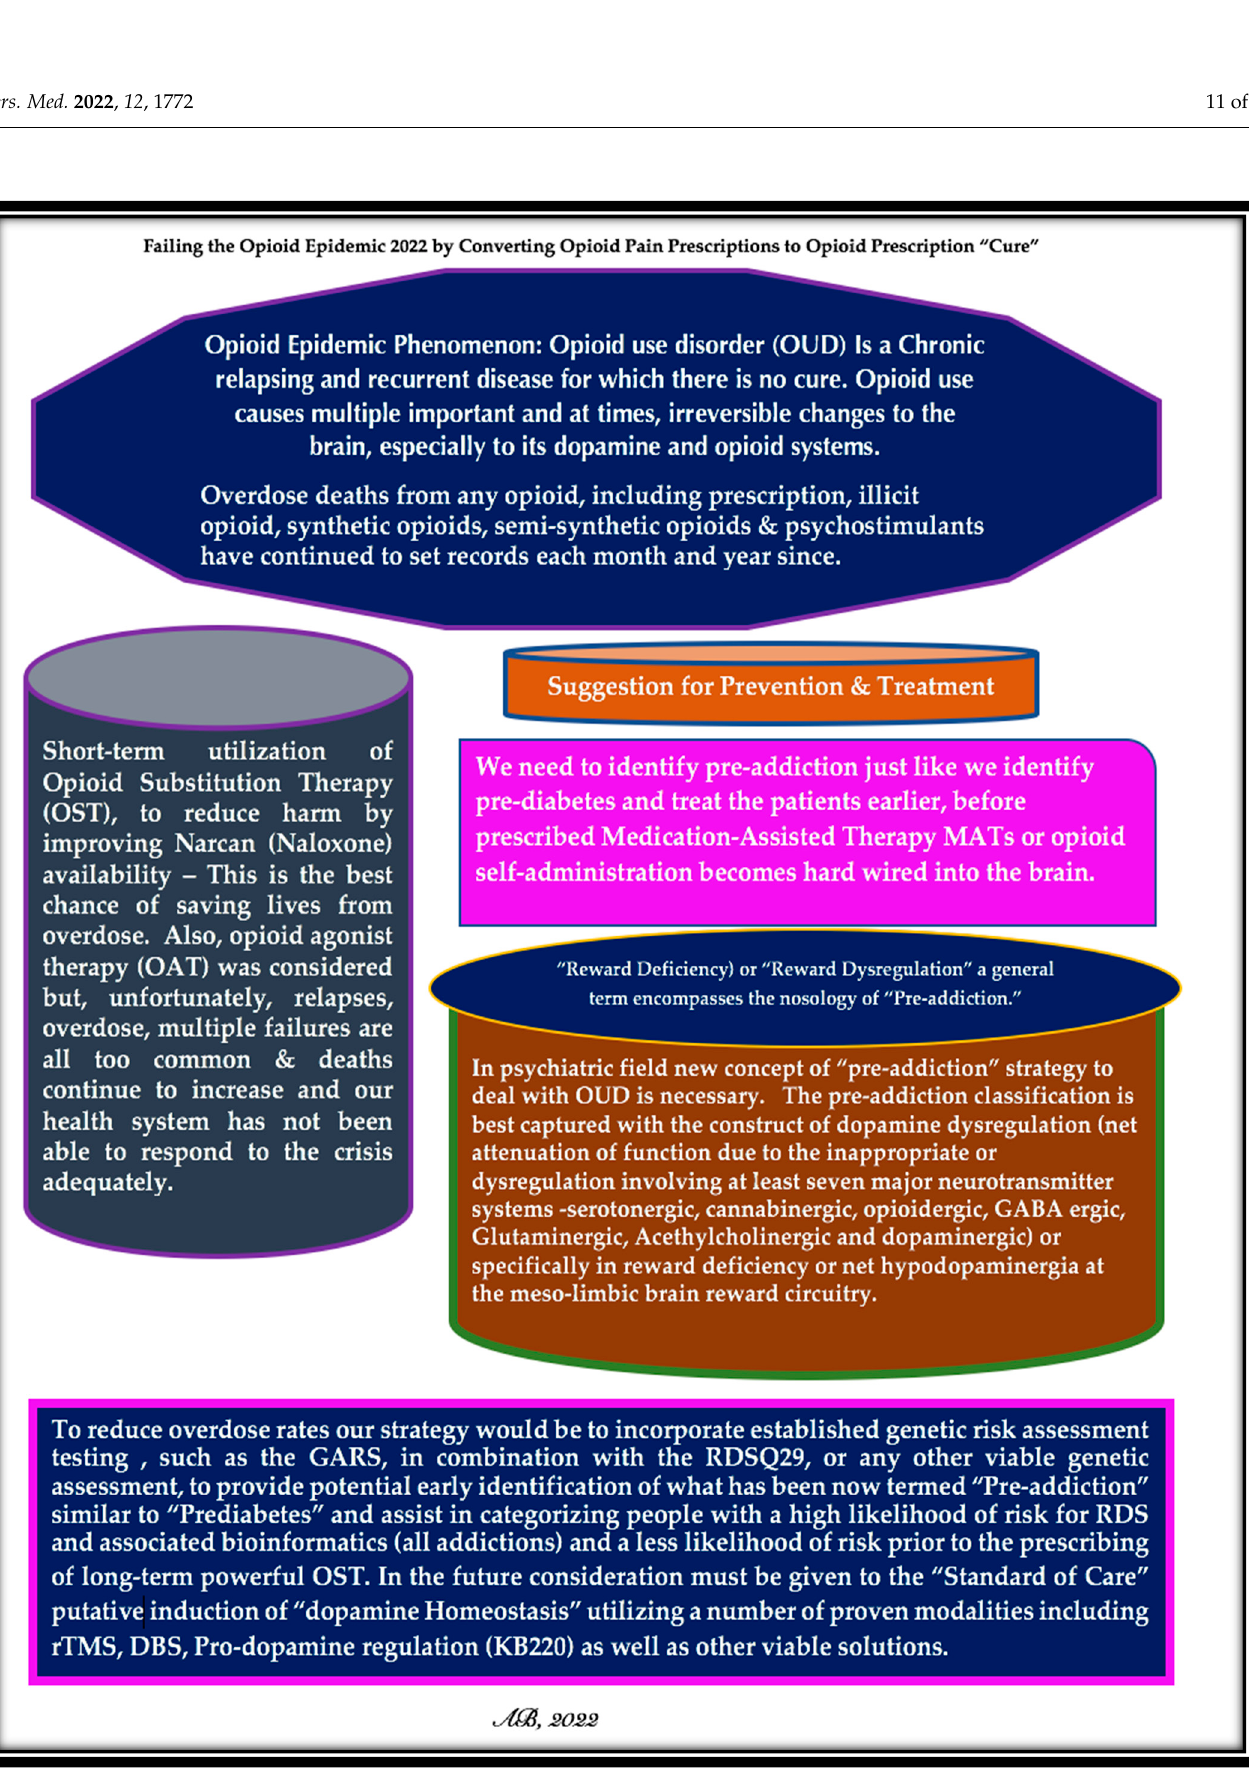
Figure 2. Schematic illustration linking the current drug abuse crisis and preaddiction.